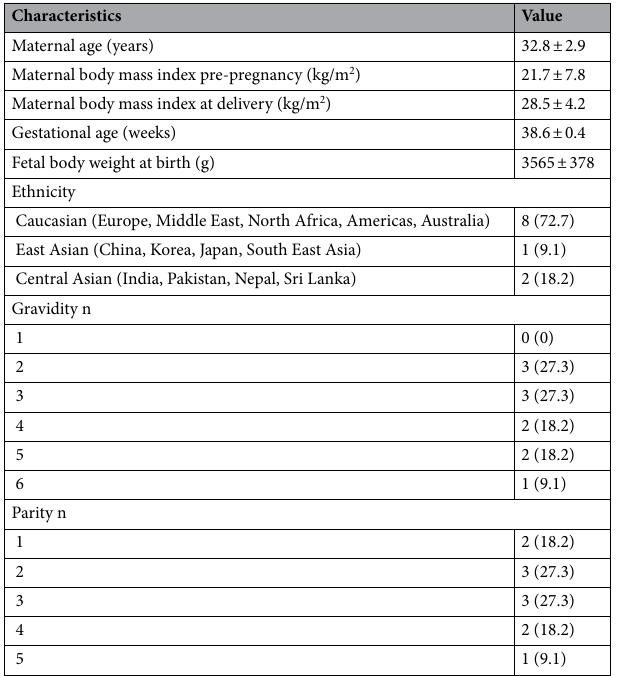
Table 1. Demographic characteristics of the pregnant patients. Continuous variables are shown as the mean ± standard deviation; categorical variables are shown as the number of cases (%).